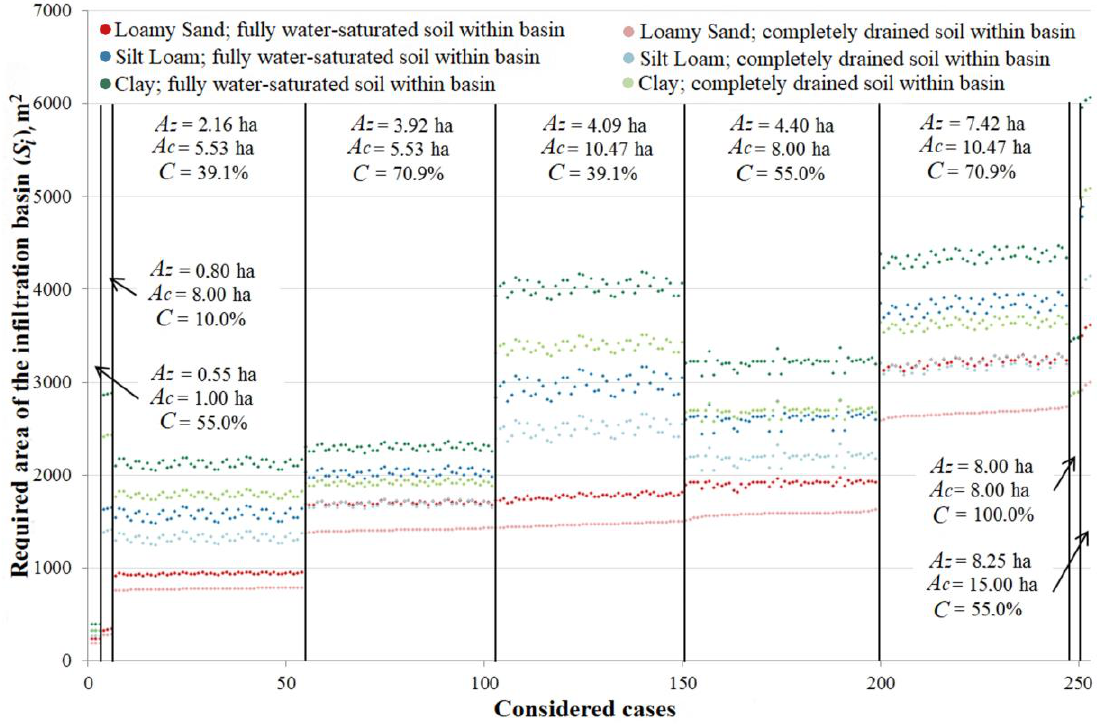
Figure 11. Results of the simulations carried out for the infiltration basin ( A z — reduced catchment area; A c — total catchment area; C — runoff coefficient).